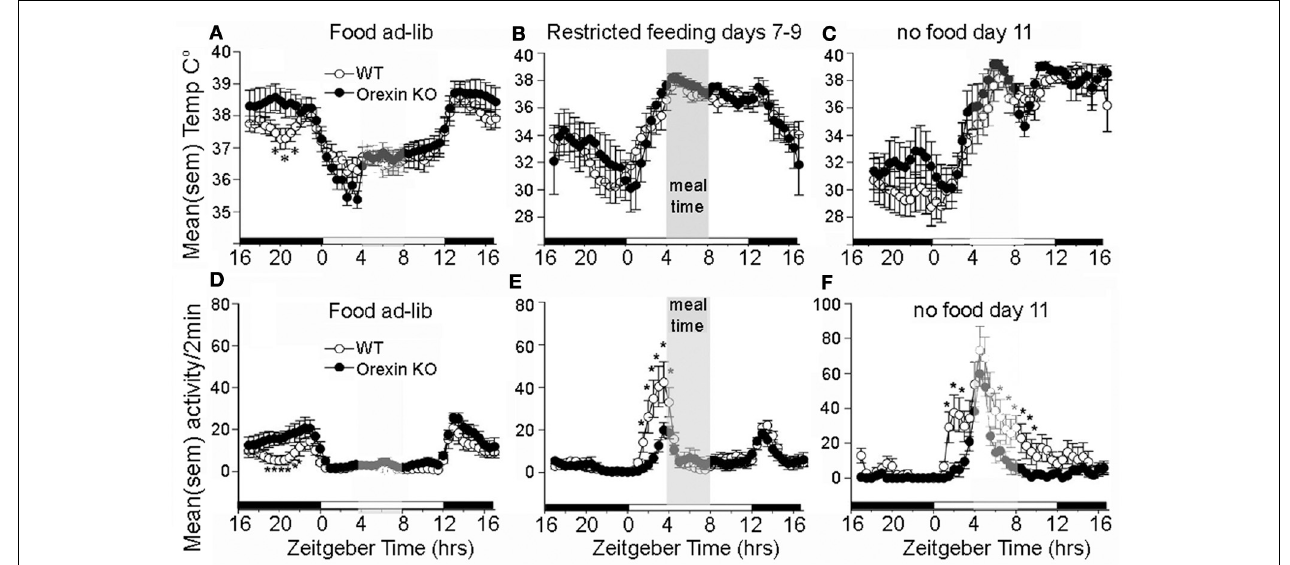
FIGURE 4 | Average waves illustrating daily rhythms of core body temperature (A–C) and locomotor activity (D–F) in WT mice (open circles) and orexin KO mice (closed circles). WT and KO mice show an equivalent anticipatory rise of body temperature prior to a 4-h daily meal (B) and this rhythm persists for at least 2 days of total food deprivation. (C) By contrast with WT mice, the KO mice exhibit